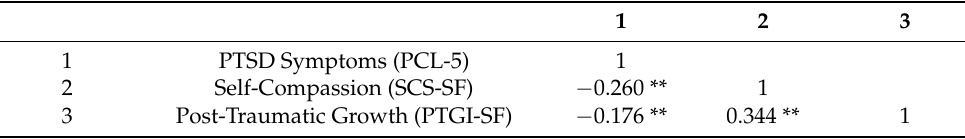
Table 4. Zero-order correlations: PTSD symptoms, self-compassion, and PTG. 1 2 3 1 PTSD Symptoms (PCL-5) Self-Compassion (SCS-SF) − 0.260 ** 3 Post-Traumatic Growth (PTGI-SF) − 0.176 ** 0.344 ** 1 Note. ** Correlation is significant at the 0.01 level